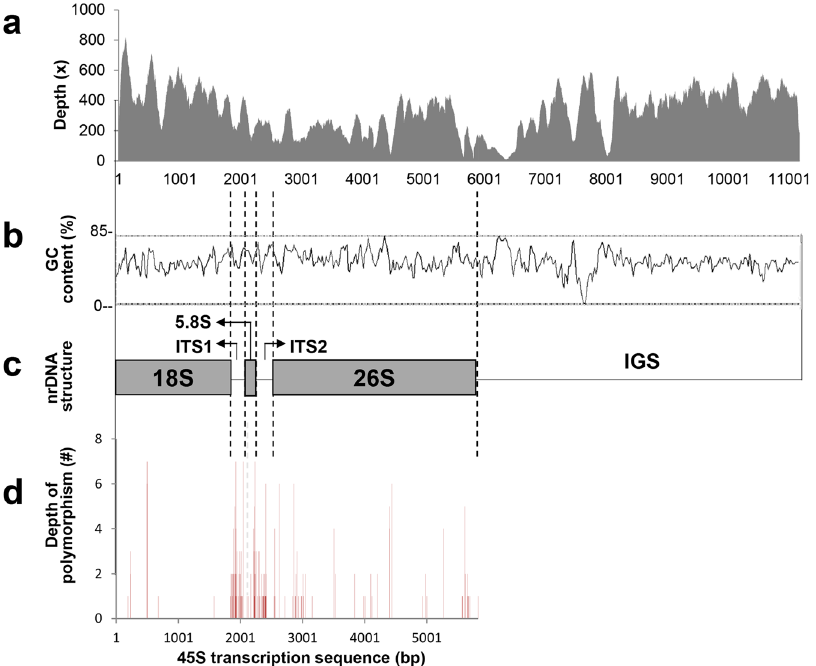
Figure 4. Assembly and comparison of 45S nrDNA sequences. ( a – c ) Full-length 45S nrDNA sequence of P. quinquefolius assembled in this study. Average read depth was 376 × ( a ) and average GC content was 53.15% ( b ). ( c ) Schematic diagram of 45S nrDNA structure. ( d ) Comparison of 45S nrDNA transcription sequences of eight Araliaceae species. P. ginseng 45S nrDNA transcription sequence (KM036295) was used as reference for sequence